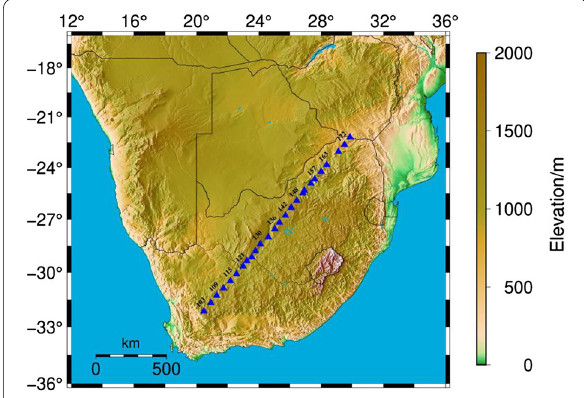
Fig. 2 Location map of KAP03. The blue triangles denote the observation site. Data for the sites in the middle of the profile (site 127–site 145 of KAP03) were heavily contaminated by direct current (DC)